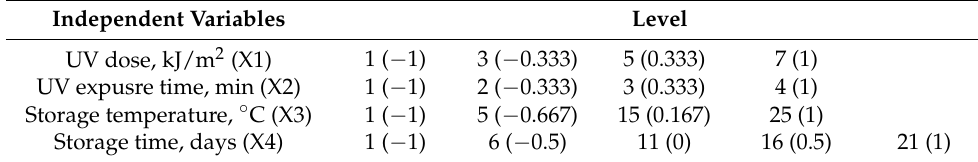
Table 2. Independent variables and their level used for central composite